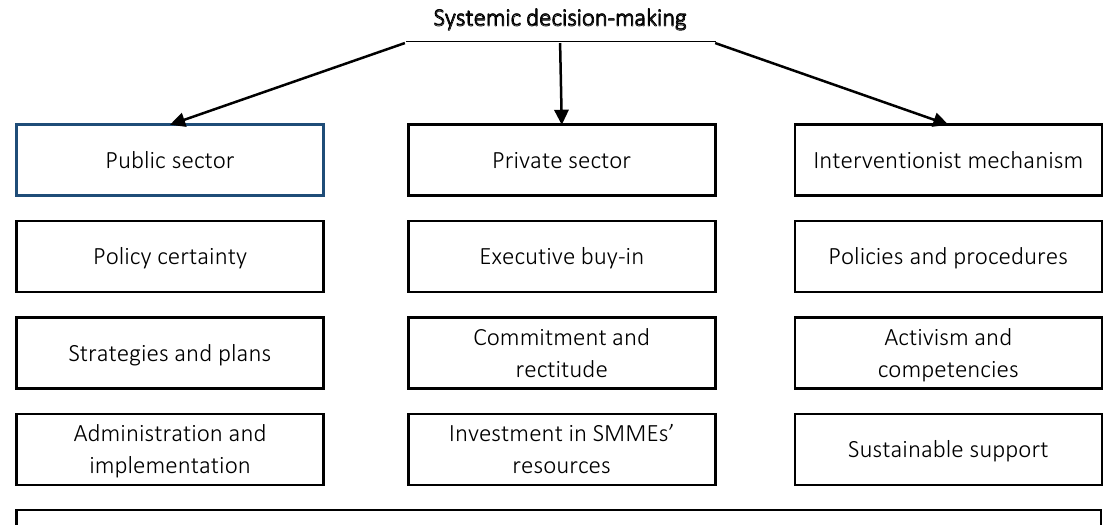
Figure 1. Architect of sustainable youth SMMEs in the urban agriculture support